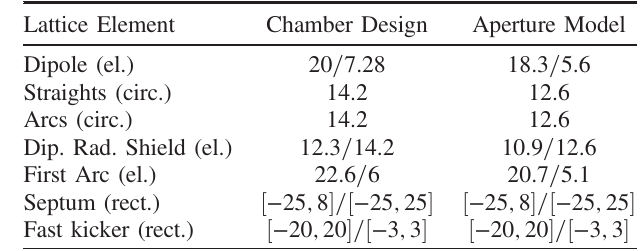
TABLE IV. AR vacuum chamber design (inner values) and the corresponding values for the aperture model. Given are the numbers in case of a circular (circ.) aperture the radius r , for =r elliptical (el.) the half axes radii r and for rectangular x y